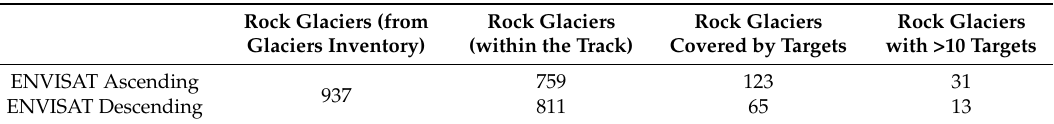
Table 4. Summary of the number of rock glaciers, inventoried in the Glacier Inventory, covered by targets generated by the GPOD-SBAS process. Rock Glaciers (from Rock Glaciers Rock Glaciers Rock Glaciers Glaciers Inventory) (within the Track) Covered by Targets with >10 Targets ENVISAT Ascending 759 123 31 937 ENVISAT Descending 811 65